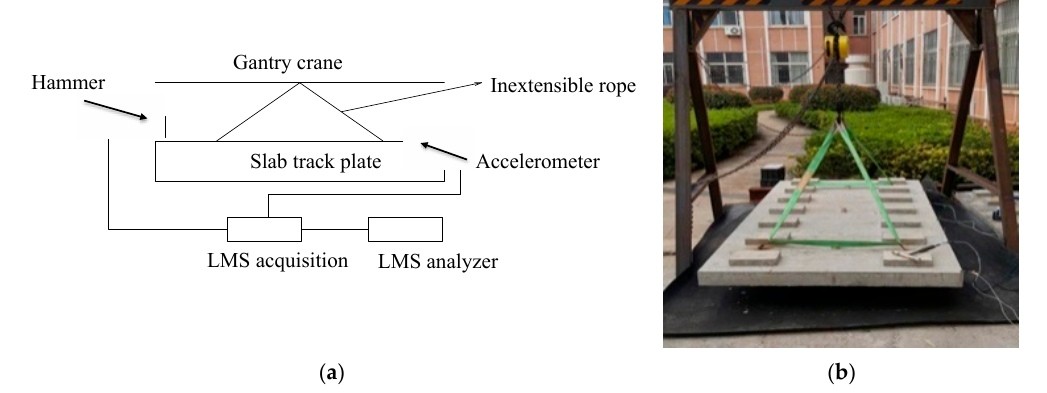
Figure 6. ( a ) Testing diagram for slab track plate; ( b ) Free-free mode testing instrumentation.